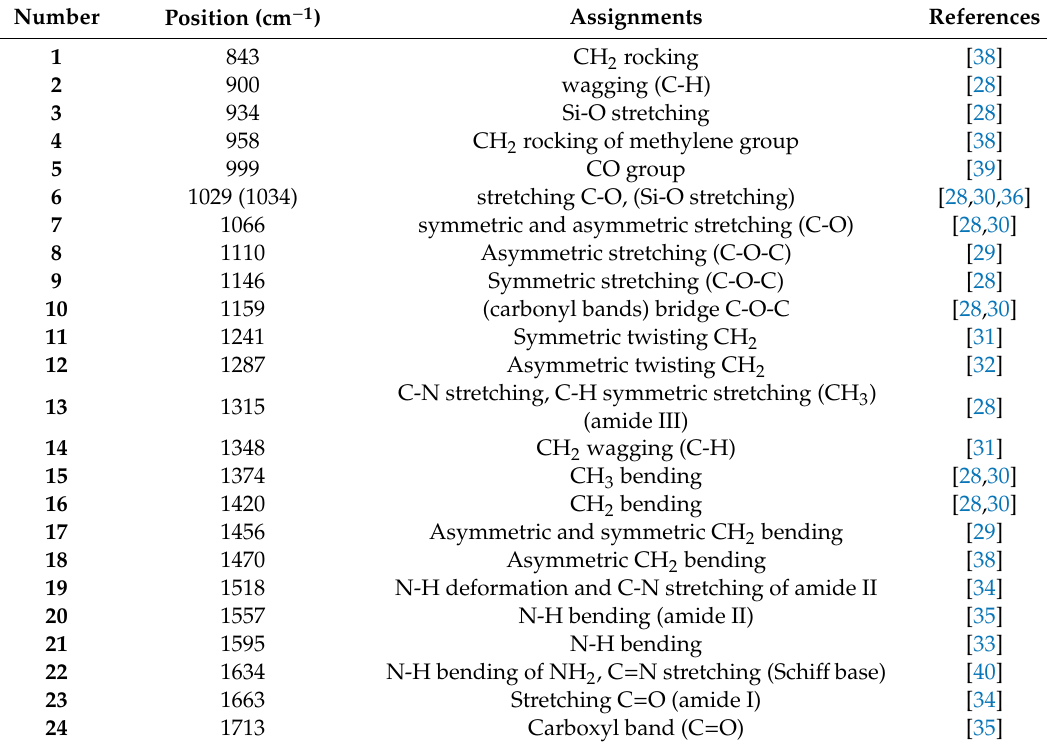
Table 1. List of FTIR band assignments related to CS / PEO and CS / PEO /